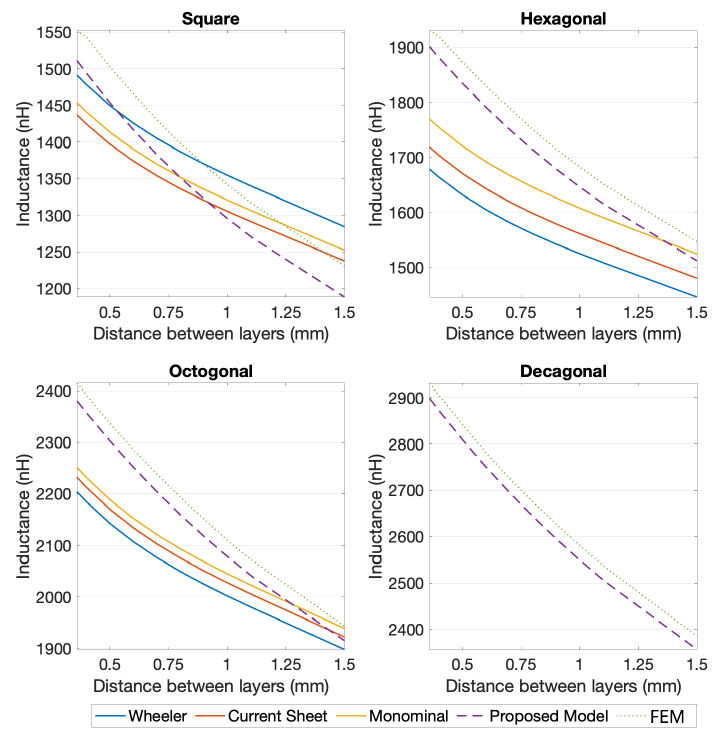
Figure 13. Comparison between several methods of inductance calculation of 2-layer coils with 10 turns, for L 0 = 1.3 mm, w = s = 0.15 mm, and for 4, 6, 8, and 10 segments per